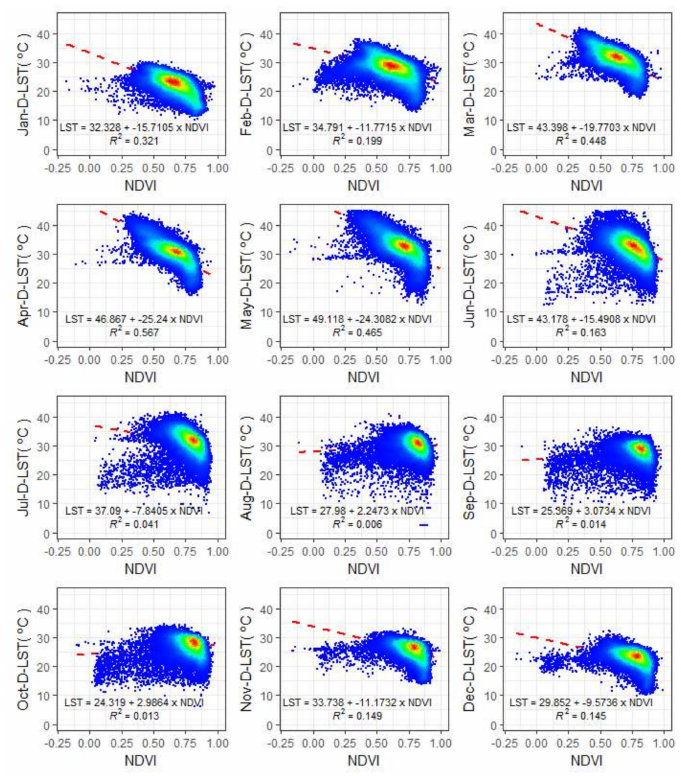
Figure A3. Scatter plots showing the relationship between the average monthly daytime LST and NDVI in northwest Vietnam in 2015. The color ramp from blue to red expresses the point density from low to